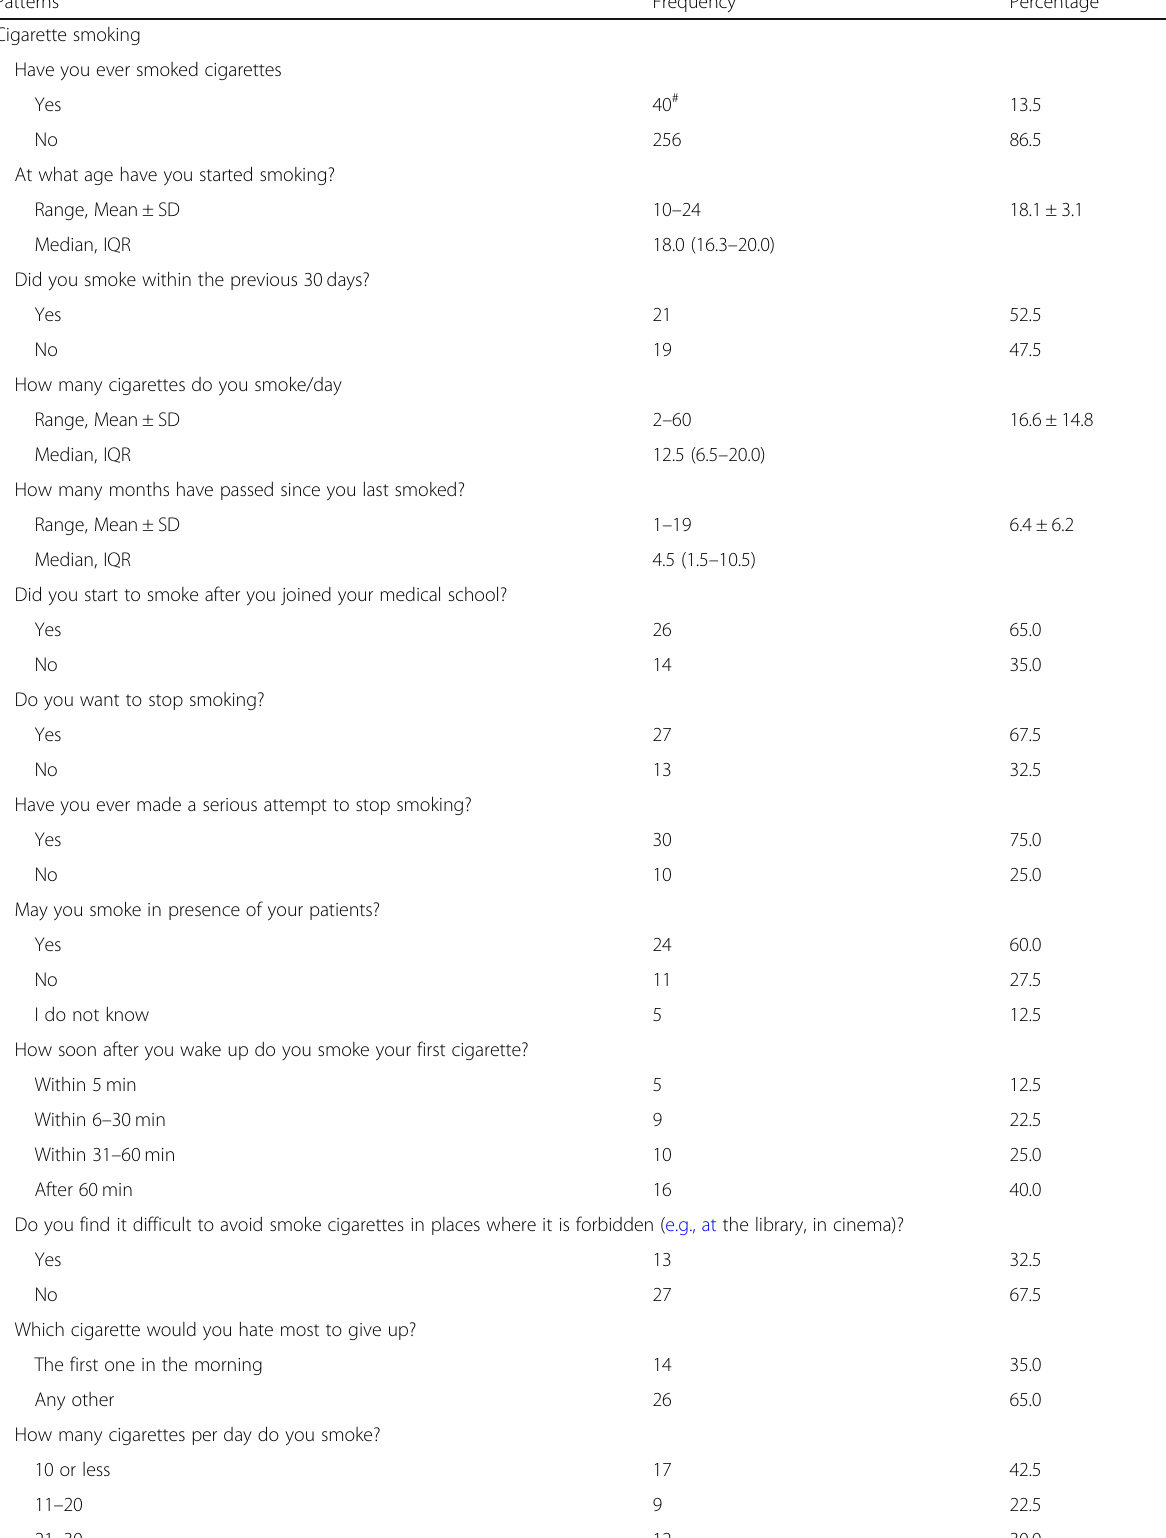
Table 4 Patterns and frequency of smoking and bango use among students, Cairo University, academic year 2014 – 2015 Patterns Frequency